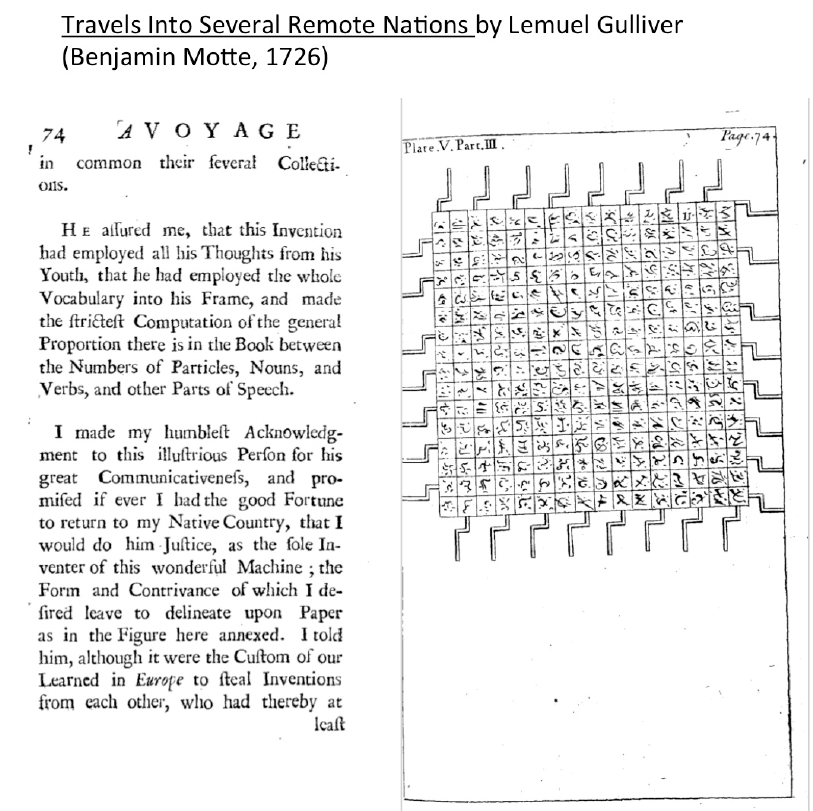
Figure 1. Illustration of “the Engine” from Book 3 of the second edition of Jonathan Swift’s Travels Into Several Remote Nations by Lemuel Gulliver ( Benjamin Motte, 1726) (Swift 1726).